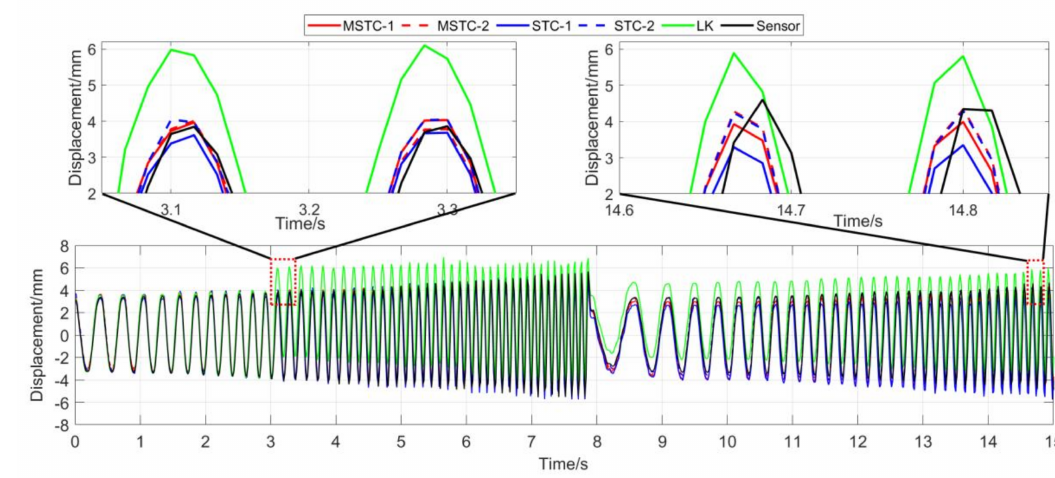
Figure 17. Displacement time history and local amplification in Scenario II (60 FPS).